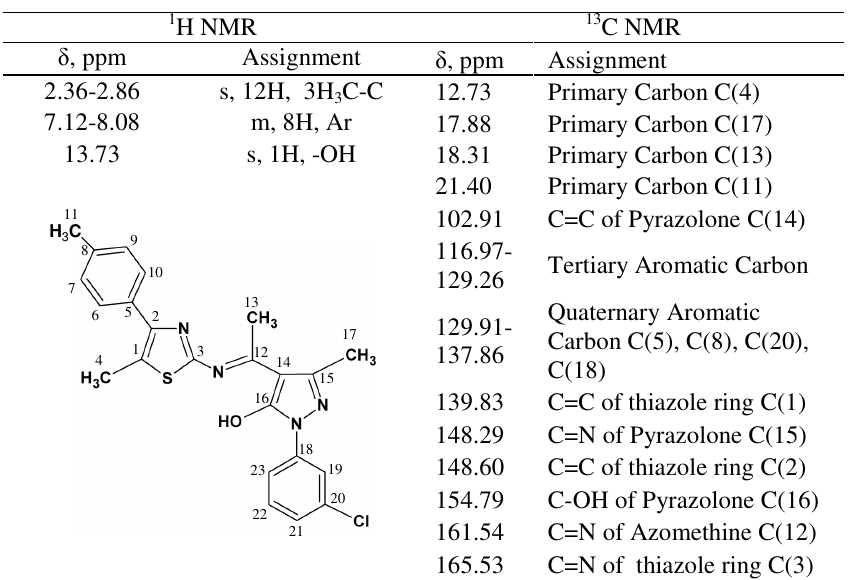
Table 3. The NMR data of Schiff base ligand L